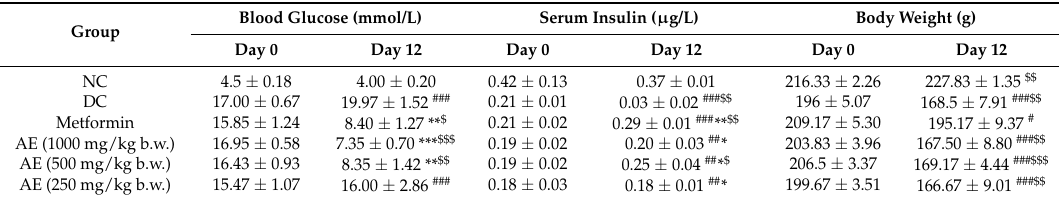
Table 1. Effect of twice daily oral administration of different doses of AE for 12 days on blood glucose level, serum insulin level and body weight of STZ-induced diabetic rats. Blood Glucose